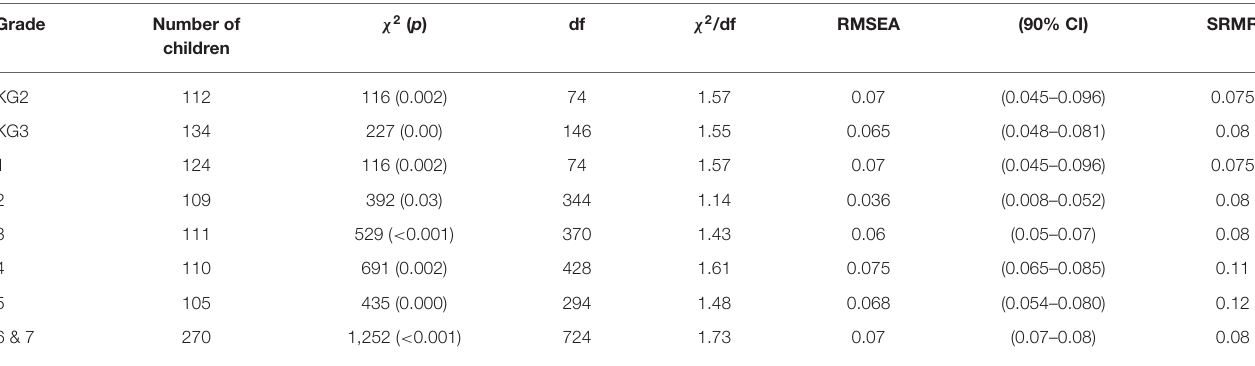
TABLE 7 | Model validity coefficients for each